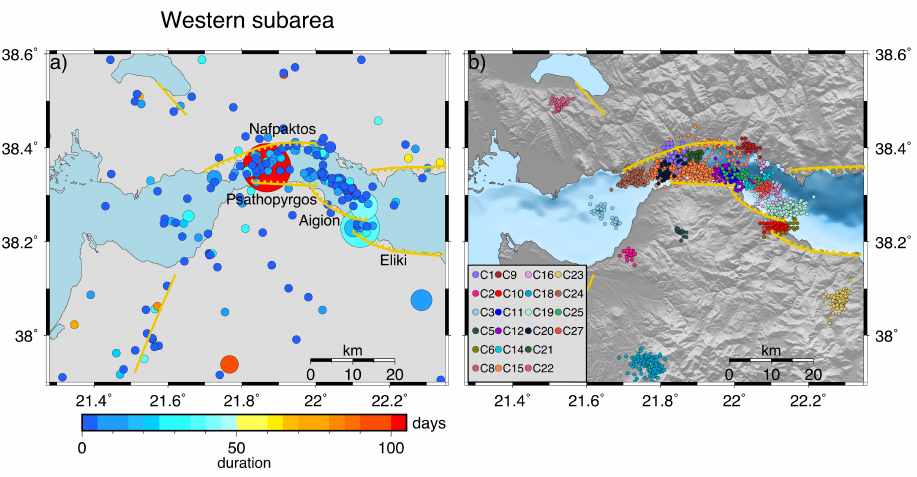
Figure 4. ( a ) Spatial distribution of the centroids of the identified clusters for the western subarea of Corinth Gulf along with major faults (yellow lines). The size of the circles is proportional to the earthquake number in each cluster, whereas the duration is represented by the color scale. ( b ) Spatial distribution of the clusters with N ≥ 30 events. The index of each cluster is provided in the inset